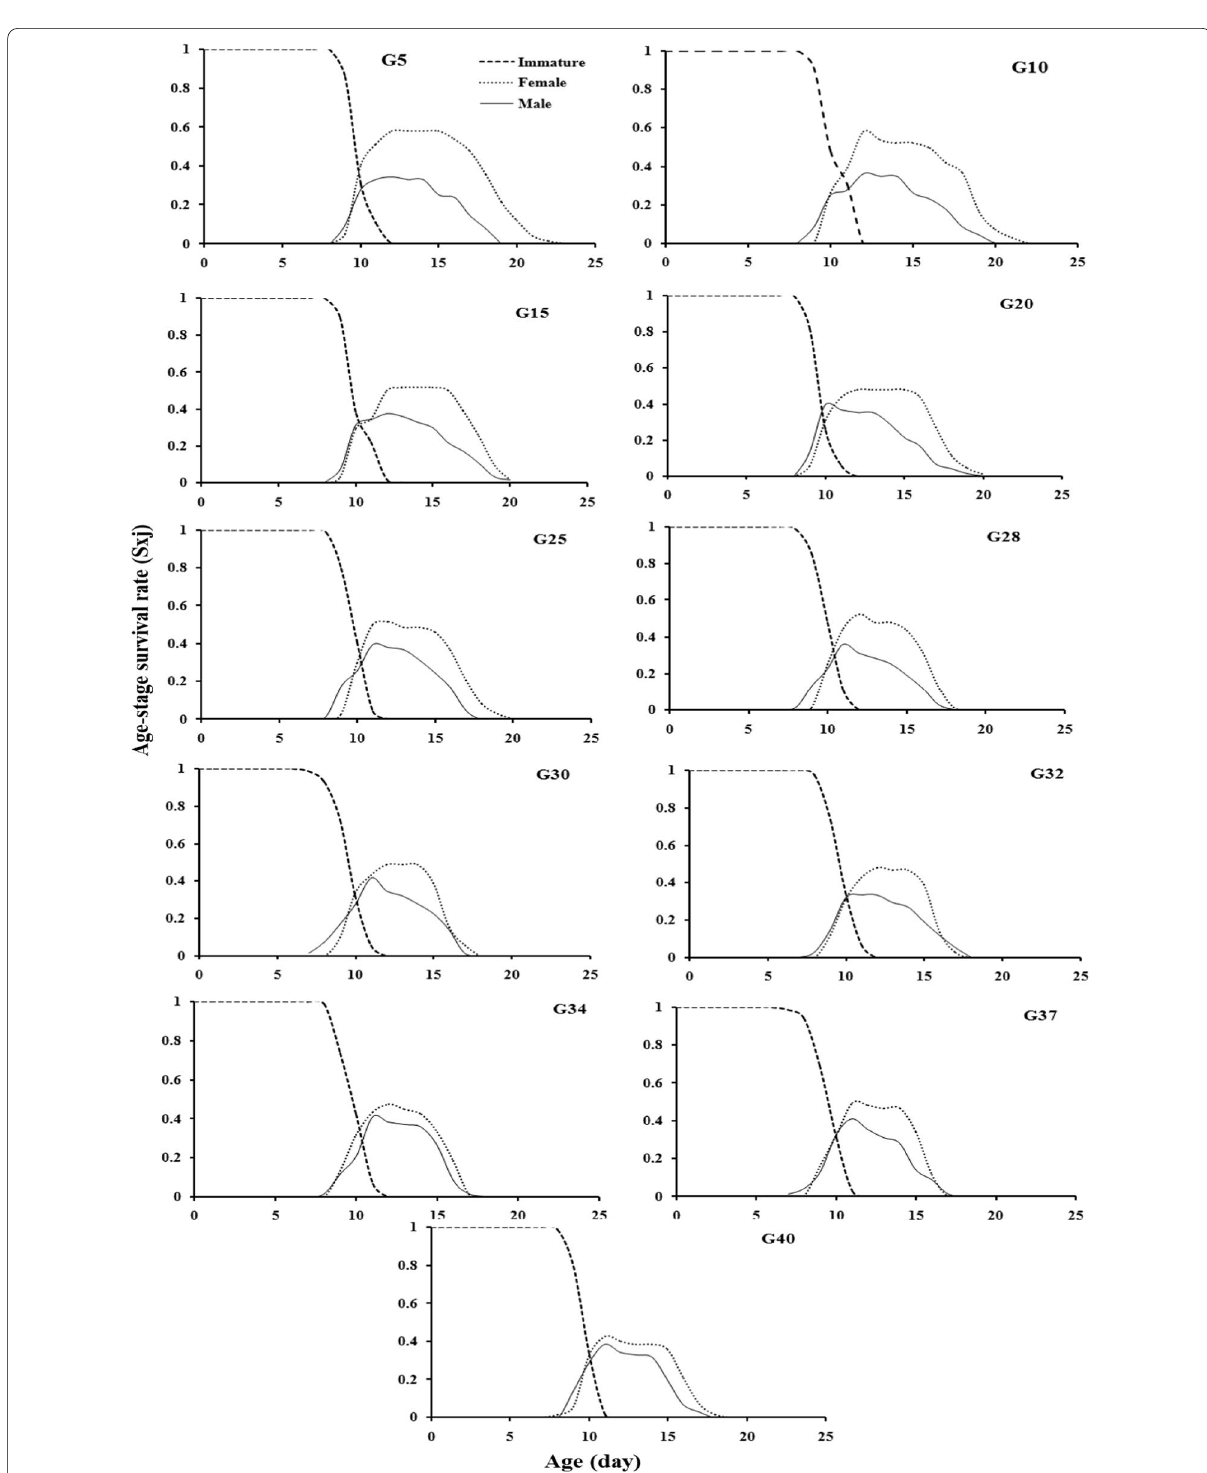
Fig. 1 The age-stage survival rate ( s xj ) of sequential generations (G) of T. embryophagum reared on S. cerealella